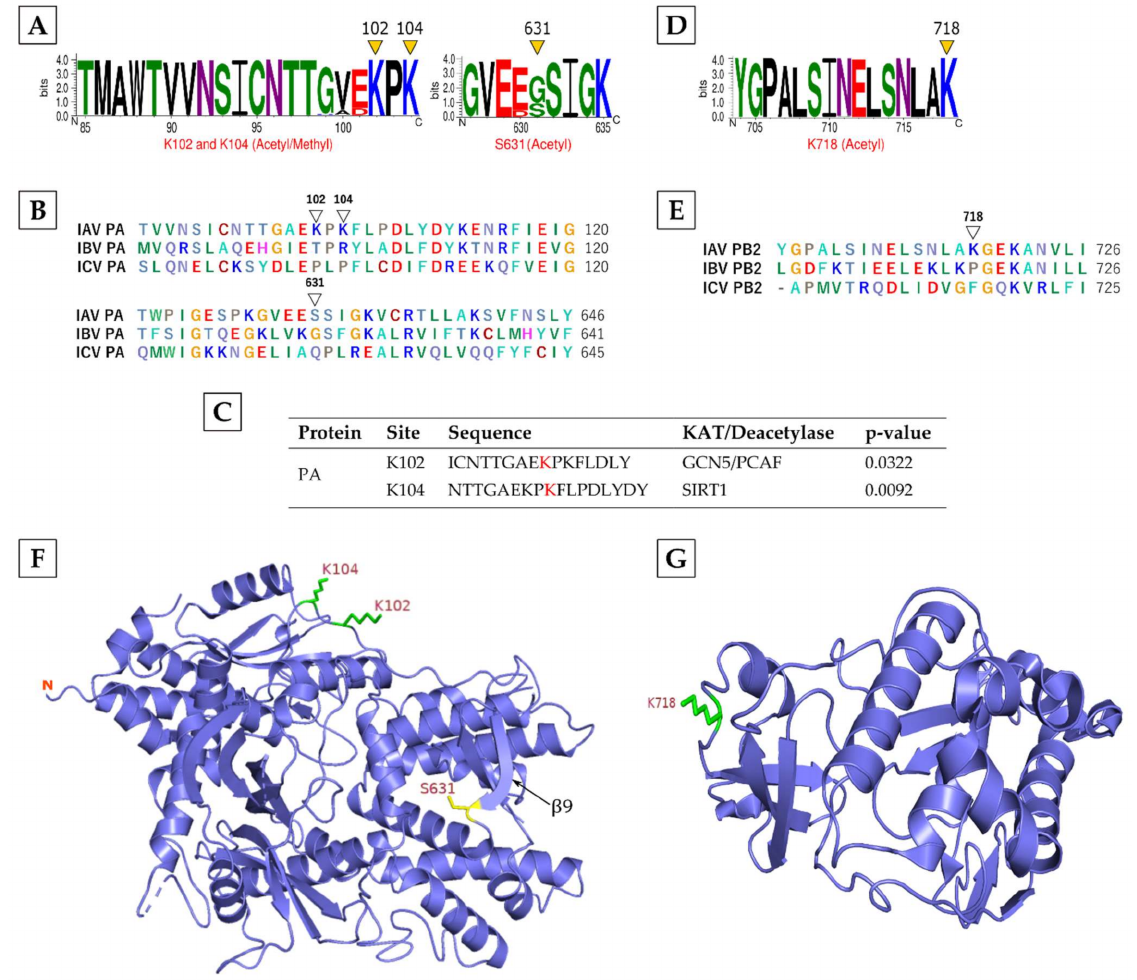
Figure 3. The characteristics of the modifications on IAV PA and PB2. Conservation of modified residues in PA ( A ) and PB2 ( D ) across IAV subtypes. A total of 800 PA and 986 PB2 sequences from 48 different IAV subtype strains were aligned in BioEdit using ClustalW and visualised by WebLogo. The logos represent individual peptides with modified residues (yellow arrowheads). The X -axis indicates the position of amino acid and the Y -axis indicates the bit score on a scale of 1–4 (A scale of 4 means 100% conservation). Acetyl: acetylation, Methyl: methylation. Conservation of modified residues in PA ( B ) and PB2 ( E ) across IAV, IBV, and ICV. White arrowheads point to no conservation. ( C ) Prediction of identified acetylated sites (in red) to be acetylated or deacetylated by ASEB web software. Location of modified residues in the PA ( F ) and PB2 C-terminal domain ( G ) structures. The green atom stick indicates the location on loop regions, yellow atom stick indicates the location on β -strand. N, N-terminal